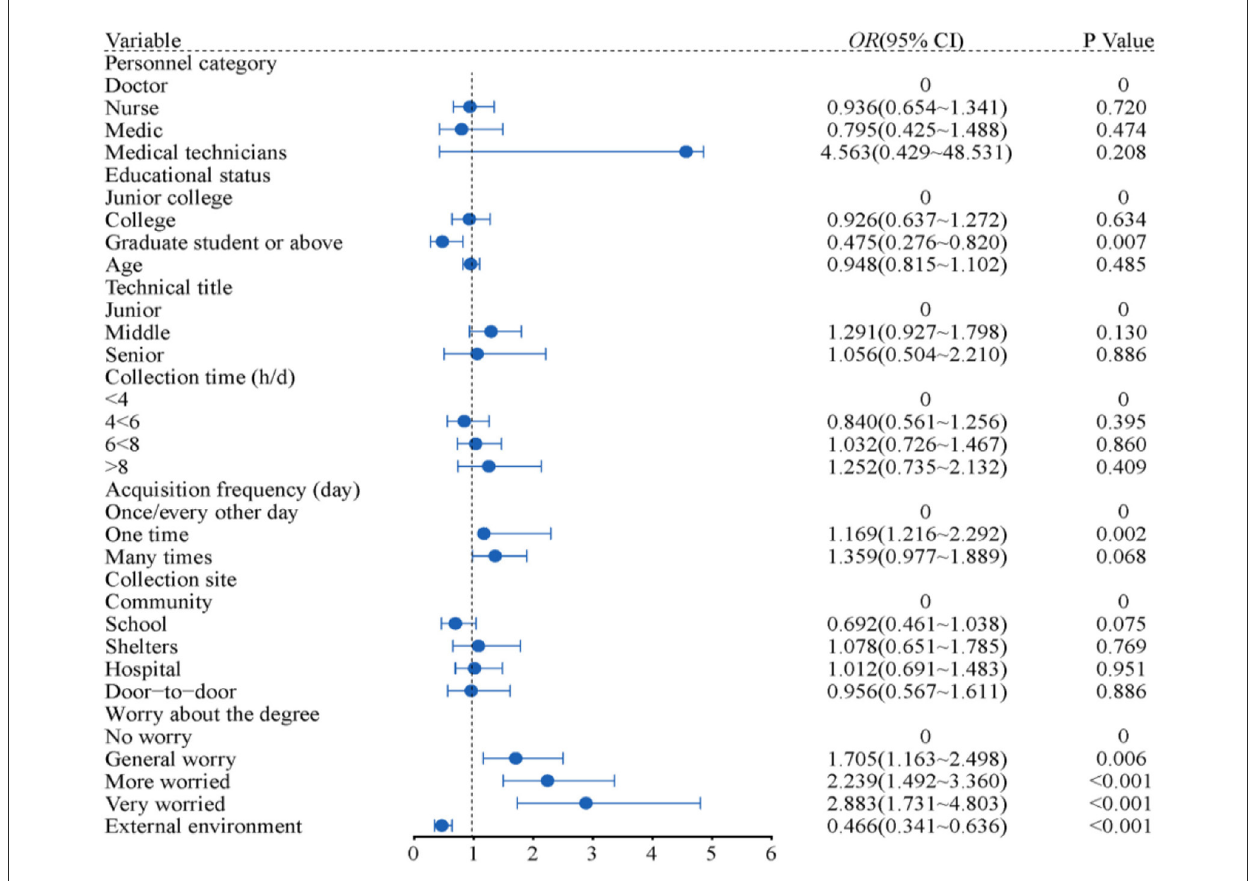
FIGURE3 Results of binary logistic model to predict sleep disorder factors.